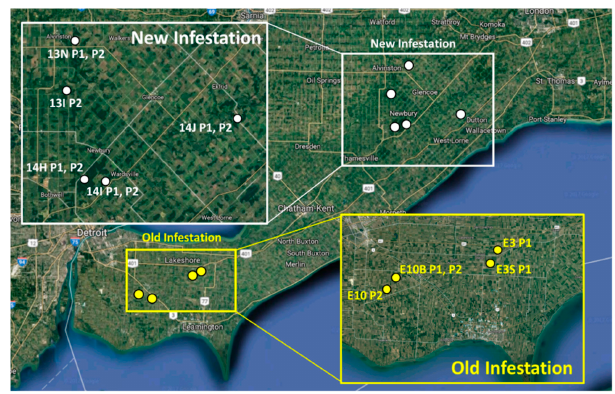
Figure 1. Locations of the 14 paired plots at the old and new infestation sites in Southwestern Ontario. Each site had two sets of paired plots spaced 50–100 m apart and, in all but one case, situated on opposite sides of the stream.